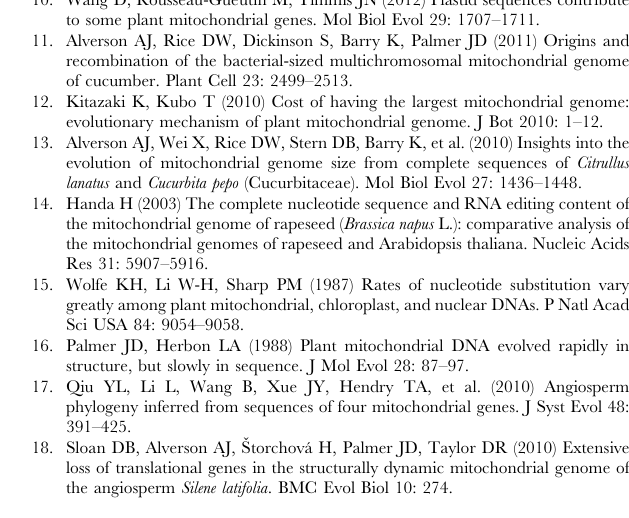
Figure S1 Phylogenetic trees of NADH dehydrogenase genes and cytochrome c biogenesis genes. The ML tree (A) and NJ